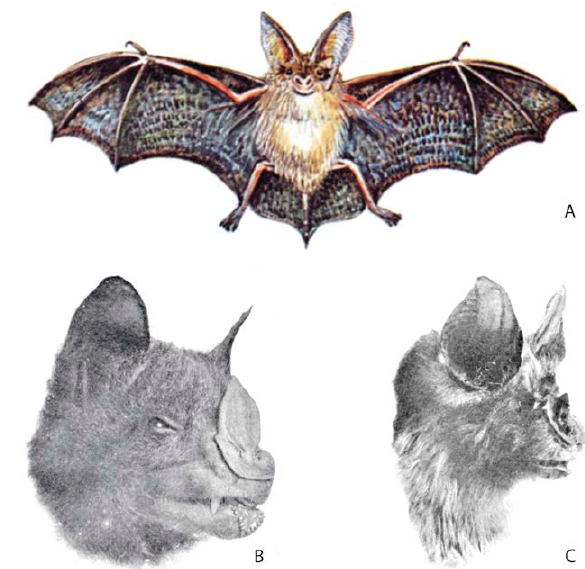
Figure 2. Three different types of facial structures of bats that repre- sent their great variation in pattern. The shape of the nose is not relat- ed to any obvious advantage to the organism. (A) Bat species (name not indicated). Common facial pattern with protruding nose. (B) Phyllostomus hastatus . Face with shape of leaf. Belongs to Family Phyl- lostomidae, New World Leaf-nosed bats. This species is called Spear- nosed bat because the leaf has a sharp point on the upper part like the leaf of many deciduous trees (e.g. Oaks, Elms, Mangolias and others). (C) Rhinolophus ferrumequinum . Called Mediterranean Horseshoe bat. The facial pattern which resembles a horseshoe, is so striking that is included in the scientific name (ferrum = iron, equinum = horse).